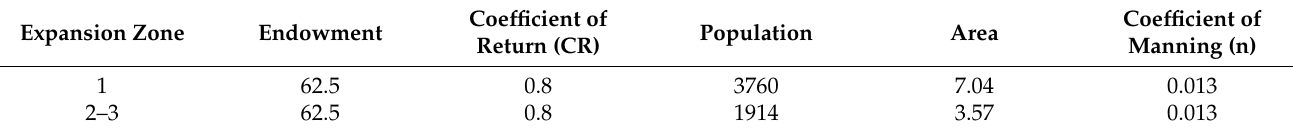
Table 6. Parameters for the calculation of design flow rates.